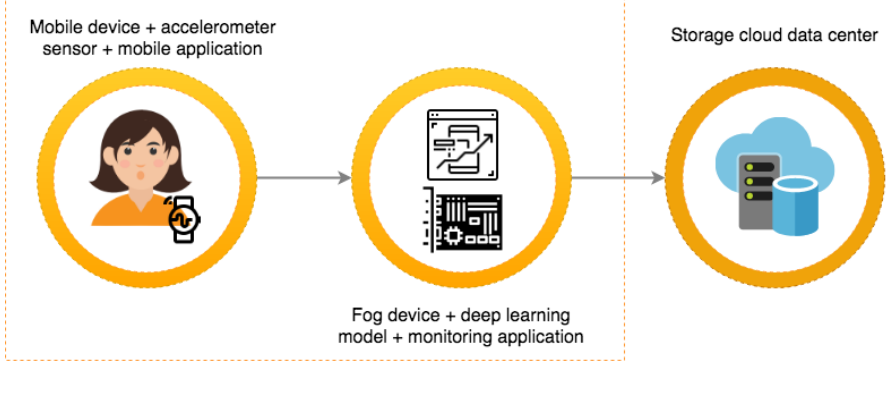
Figure 3. Simplified fall detection use case.